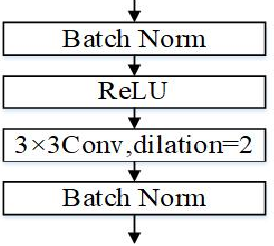
Figure 8. DC Block architecture.